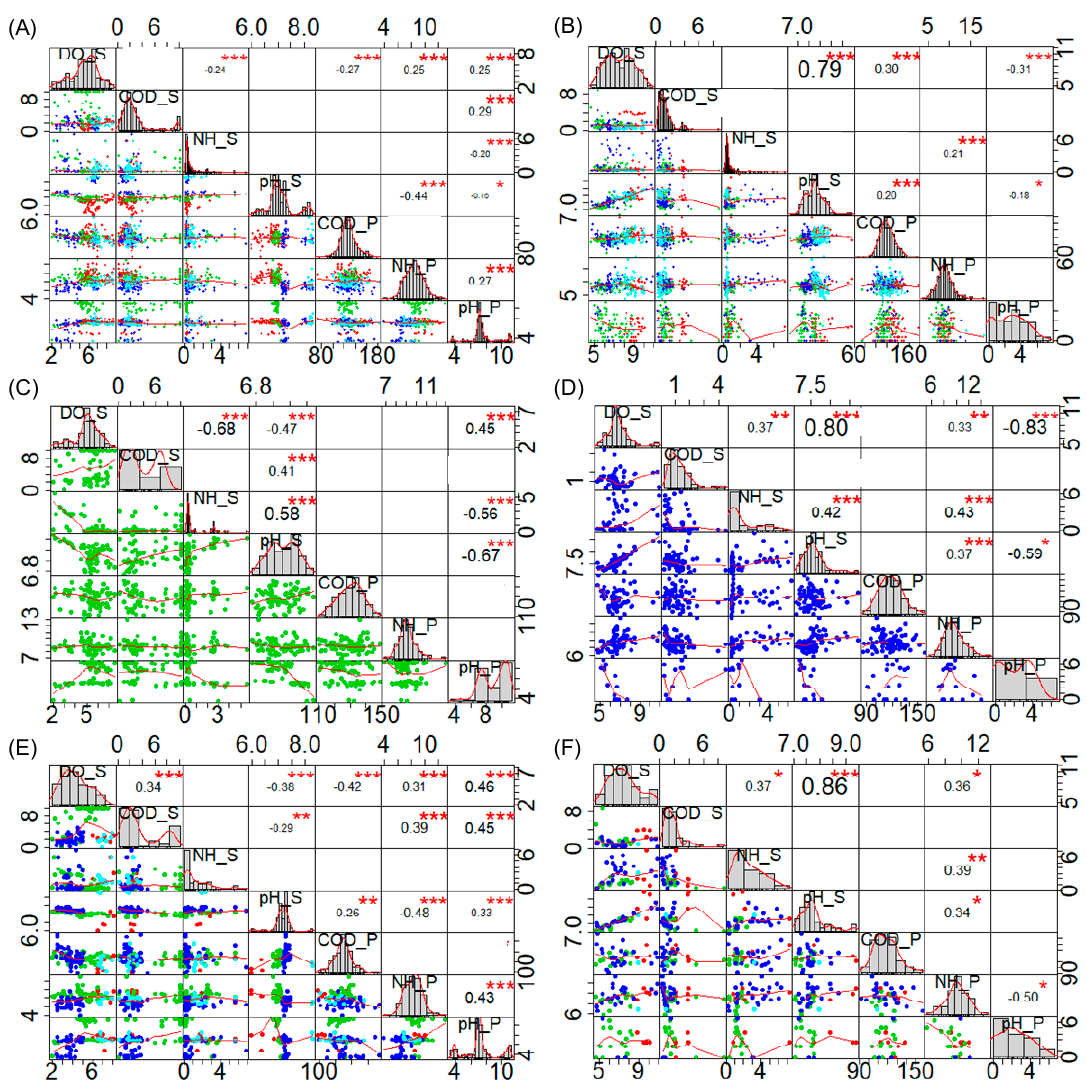
Figure 9. Spearman correlation analyses between each pair of daily means of COD, NH 3 -N, pH, and DO in surface water at HuN3 and in the HPW wastewater discharges in the HPZ zone in 2016. ( A : daily samples in the whole year; C : daily samples in the second quarter; E : daily samples with polluted water at HuN3) and 2017 ( B : daily samples in the whole year; D : daily samples in the second quarter; F : daily samples with polluted water at HuN3). (DO_S, COD_S, NH_S, and pH_S represent DO, COD, NH 3 -H, and pH in surface water at HuN3. COD_P, NH_P, and pH_P represent COD, NH 3 -H, and pH in the HPW discharge wastewater. In the rectangle, figures below the diagonal: points represent daily samples; the point colors represent di ff erent quarters of the year: red (the 1st quarter), green (the 2nd quarter), blue (the 3rd quarter), and cyan (the 4th quarter); the red curves represent the fitted curve. In the rectangle, figures above the diagonal: the numbers represent Spearman correlation coe ffi cients between each two variables; the font sizes represent the coe ffi cient value sizes; * represents p < 0.05; ** represents p < 0.01; *** represents p < 0.001. The diagonal figures with gray rectangles represent frequency distribution histograms of each variable.).